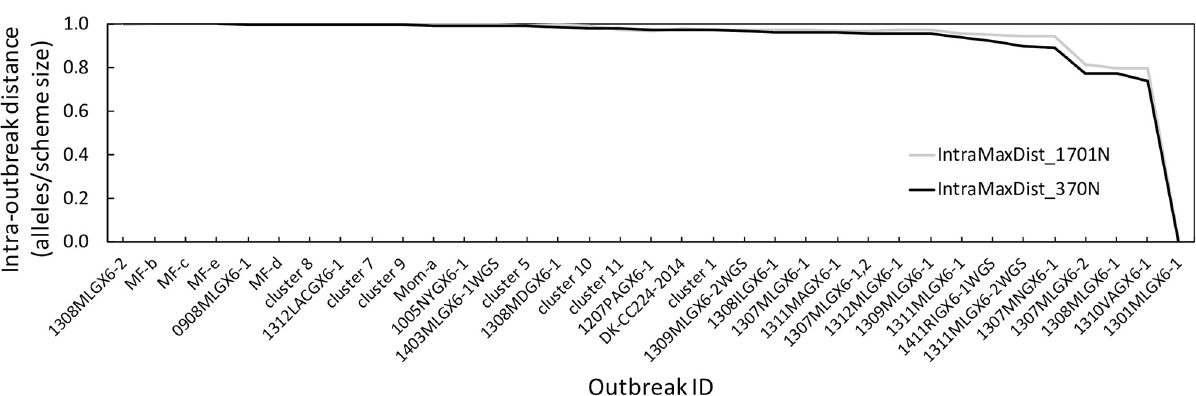
Fig 5. Maximum intraoutbreak allelic distance in the 35 outbreaks of Set B. The distance value is normalized by dividing by the scheme size (i.e., 1,701 for cgMLST and 370 for LmScheme_370). The black line indicates the distance calculated based on the LmScheme_370 scheme, and the gray line represents the distance calculated based on the Lm-cgMLST